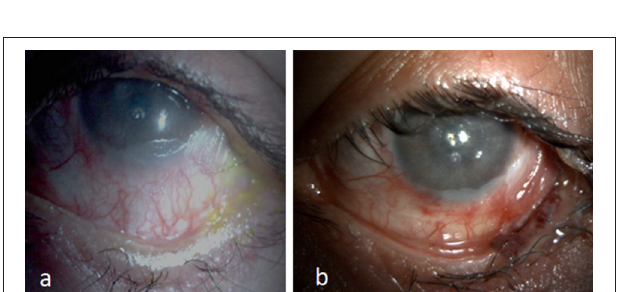
FIGURE 3 | (a) Keratinized surface with shortened fornix. (b) Two years following fornix reconstruction with mucous membrane and amniotic membrane graft with relatively moist surface and improvement in corneal luster using PROSE